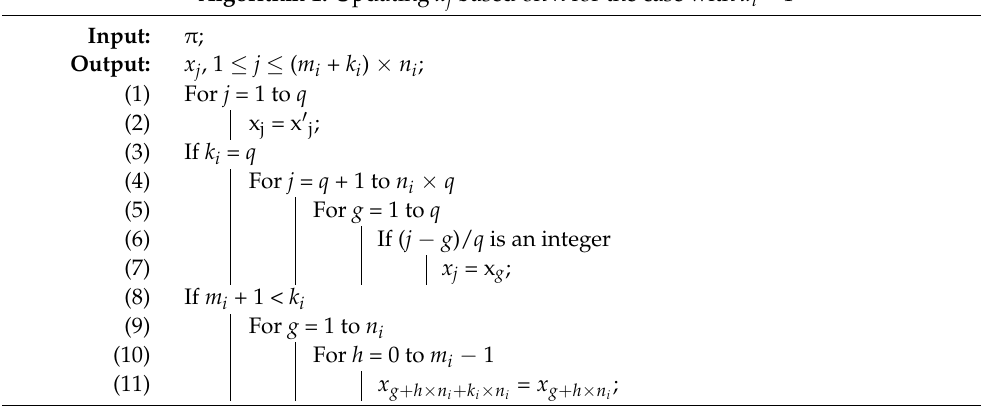
Algorithm 1. Updating x j based on π for the case with d i =